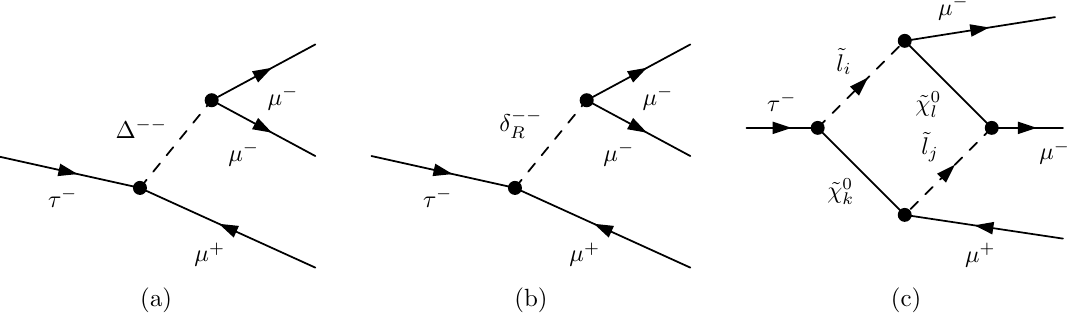
! (cid:22) (cid:7) (cid:6) (cid:22) (cid:7) (cid:22) (cid:7) in (a) the Type-II